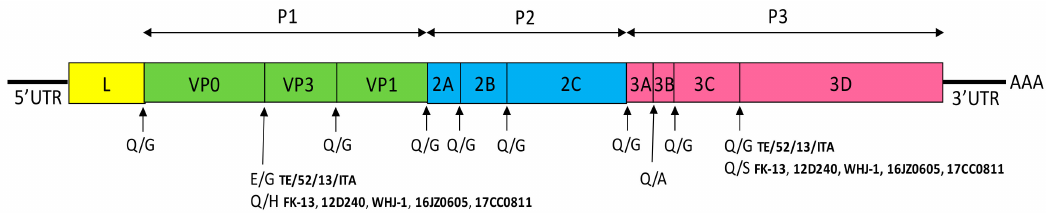
Figure 3. Schematic genome organization of FeKoV. The 5 (cid:48) UTR, 3 (cid:48) UTR, and the ORF (boxes) are indicated. The di ff erent predicted cleavage sites for the six complete genome sequences available on GenBank (TE / 52 / 13 / ITA, FK-13, 12D240, WHJ-1, 16JZ0605, 17CC0811) are shown below each gene border.